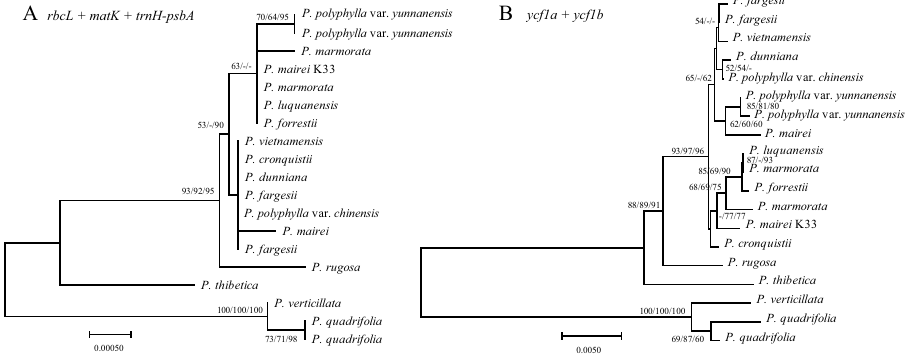
Figure 4. NJ tree for Paris using the rbcL + matK + trnH-psbA ( A ) and ycf1a + ycf1b ( B ) DNA barcode combination. NJ topology shown with NJ/MP/ML bootstrap support values were listed at each